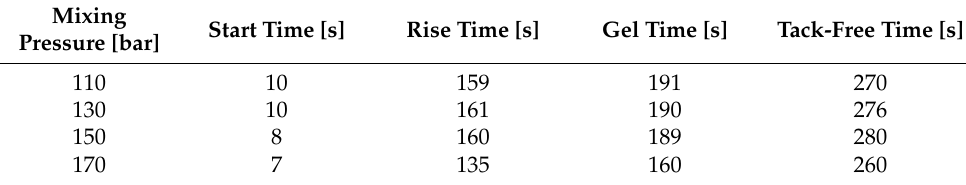
Table 2. Characteristic times for polyurethane